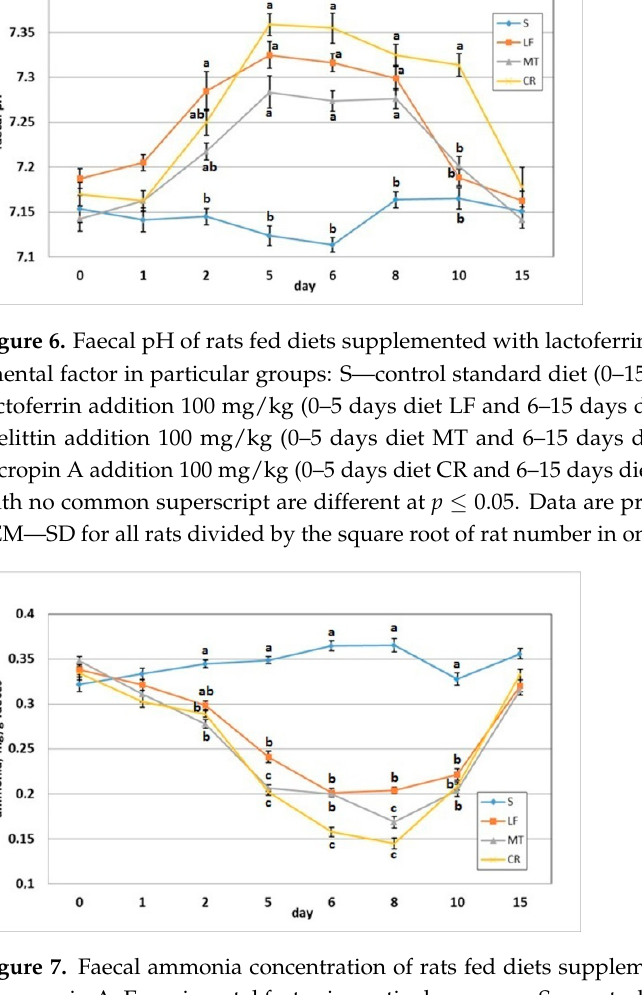
Figure 5. Total short-chain fatty acid concentration in faeces of rats fed diets supplemented with lactoferrin, melittin or cecropin A. Experimental factor in particular groups: S—control standard diet (0–15 days); LF—standard diet with lactoferrin addition 100 mg/kg (0–5 days diet LF and 6–15 days diet S); MT—standard diet with melittin addition 100 mg/kg (0–5 days diet MT and 6–15 days diet S); CR—standard diet with cecropin A addition 100 mg/kg (0–5 days diet CR and 6–15 days diet S). a,b Mean values on the day with no common superscript are different at p ≤ 0.05. Data are presented as the mean with SEM; SEM—SD for all rats divided by the square root of rat num- ber in one group ( n = 8).